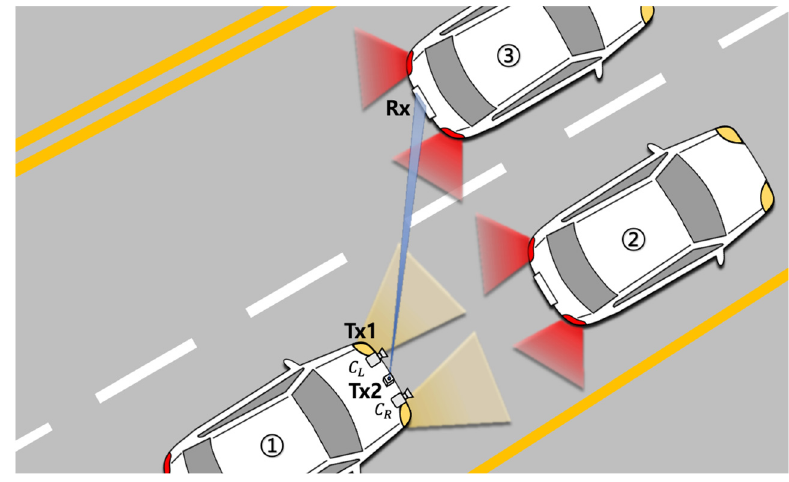
Figure 1. Illustration of the proposed V2V-VLC system.